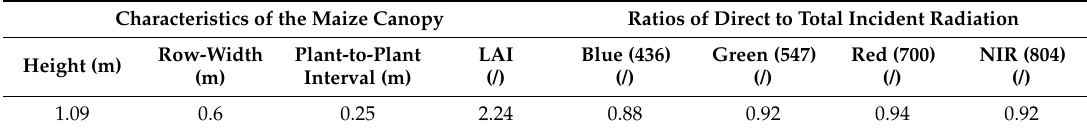
Table 1. Characteristics of maize canopy and illumination condition of canopy BRF measurements. Characteristics of the Maize Canopy Ratios of Direct to Total Incident Radiation Row-Width Plant-to-Plant Height (m) (m) Interval